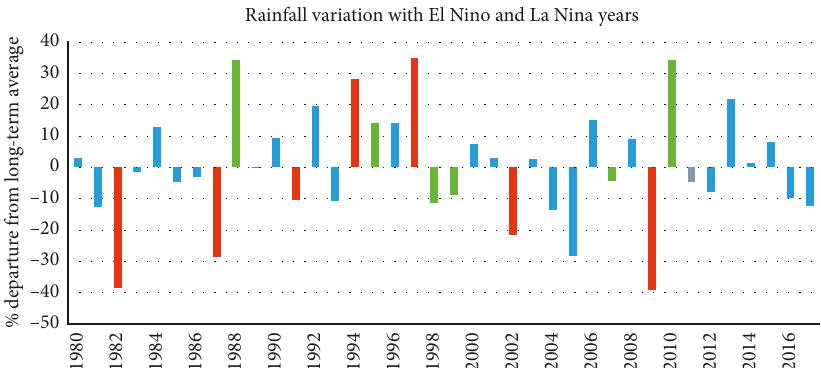
Figure 10: Impact of El Nino and La Nina years on monsoon variability in Pakistan. Red bars show the rainfall departure from long-term mean for El Nino years while green shows the same for La Nina and blue for neutral years.